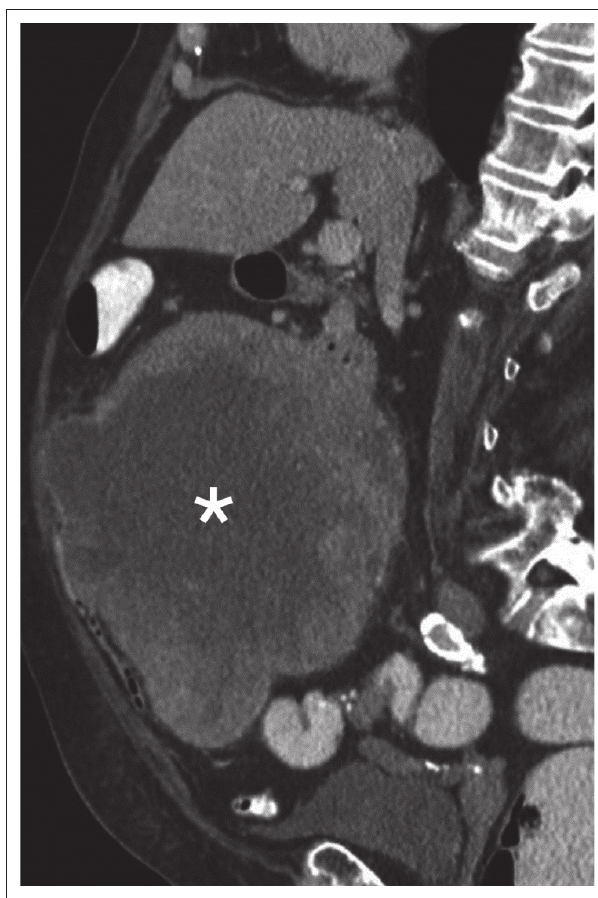
FIGURE 3: Sagittal computed tomography images of the mass (asterisk).